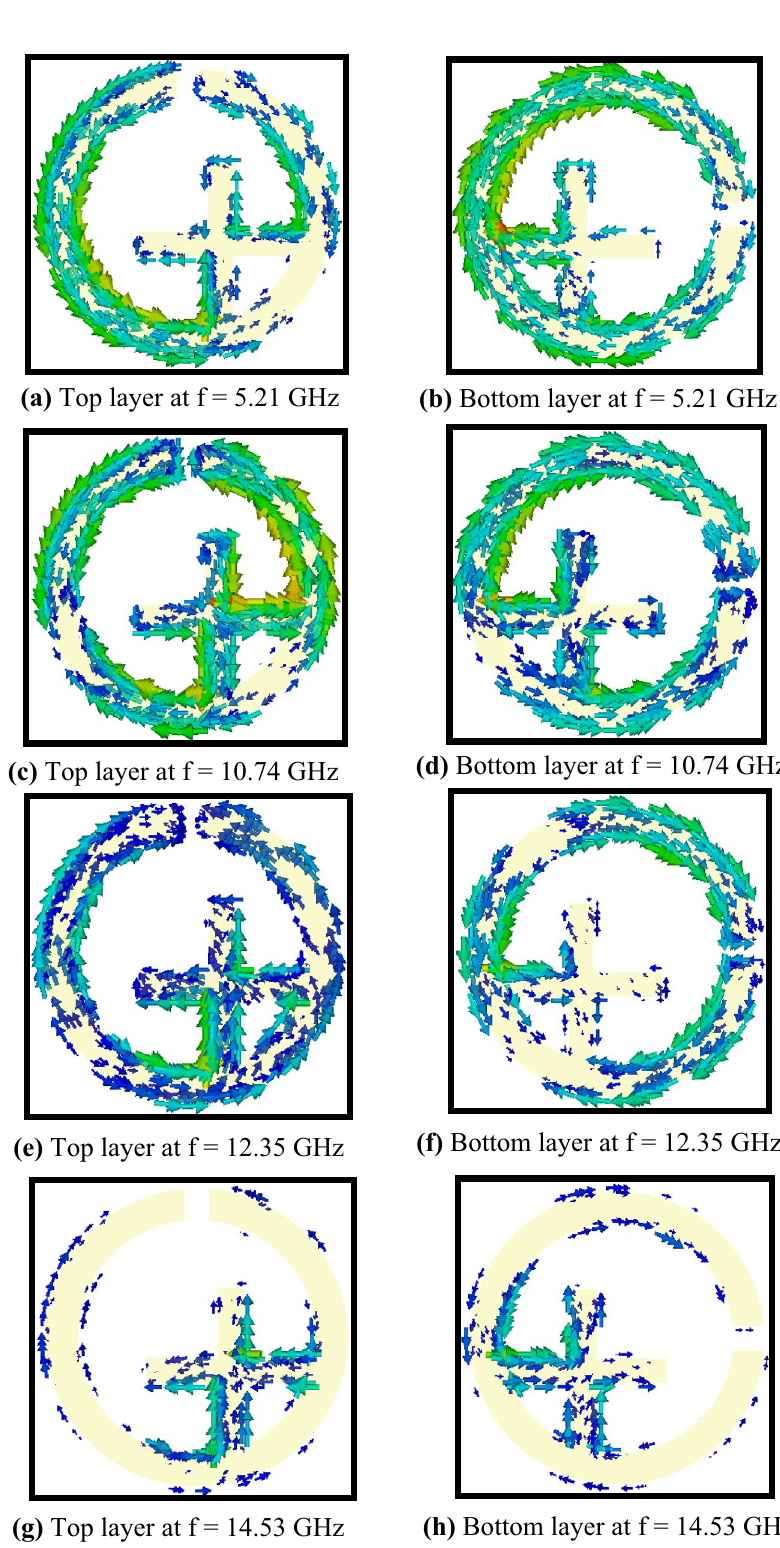
Figure 7. Surface current distributions on the top and bottom layers of the proposed metasurface at different